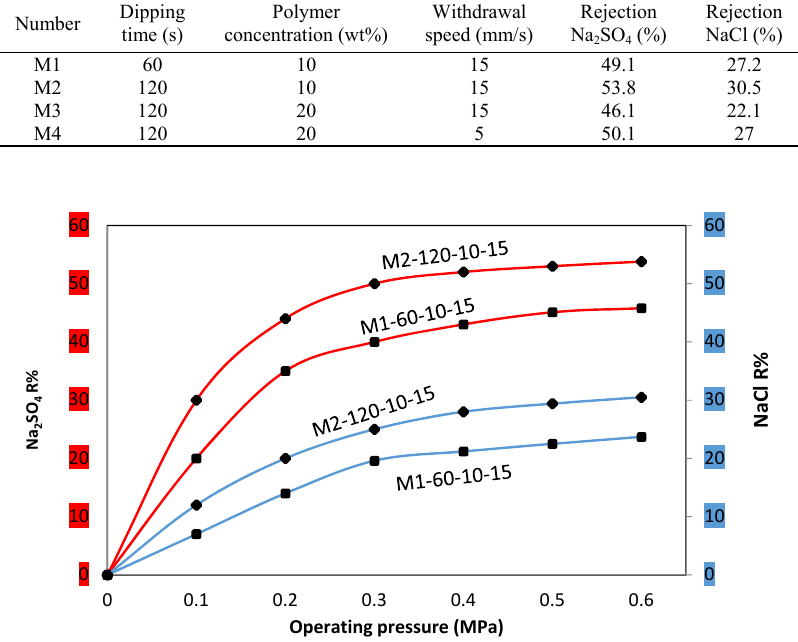
Fig. 8: Effect of operating pressure (MPa) and dip-coating parameter on the Rejection%.